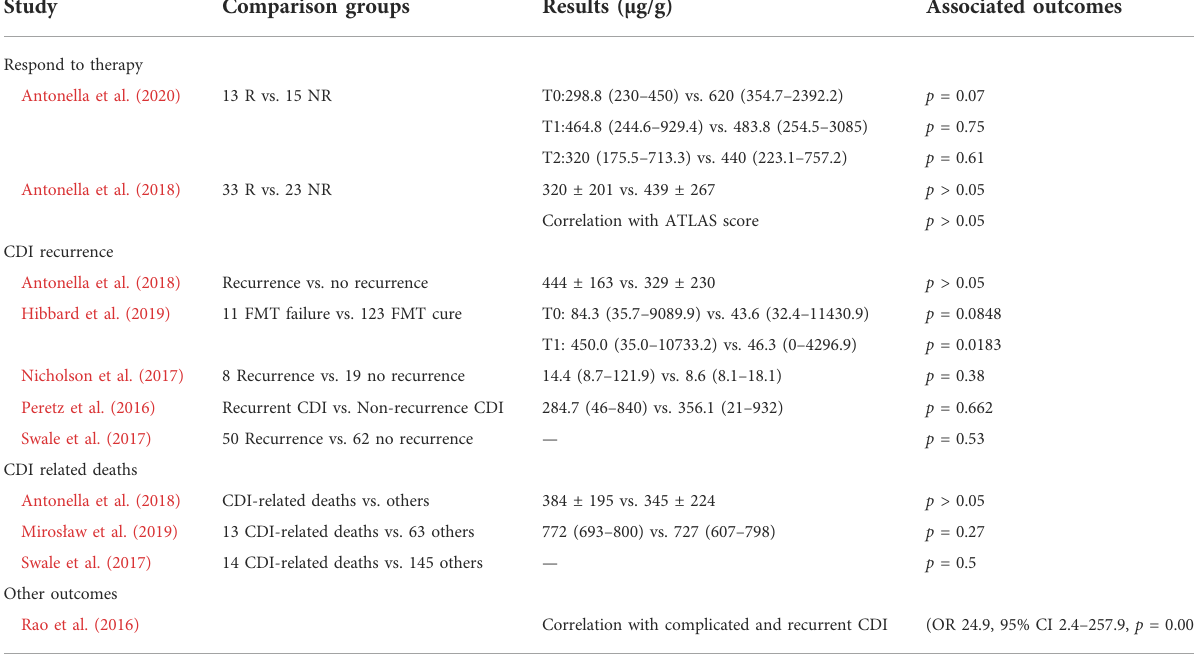
TABLE 6 Main results of studies that explored the prognostic value of fCP in patients with